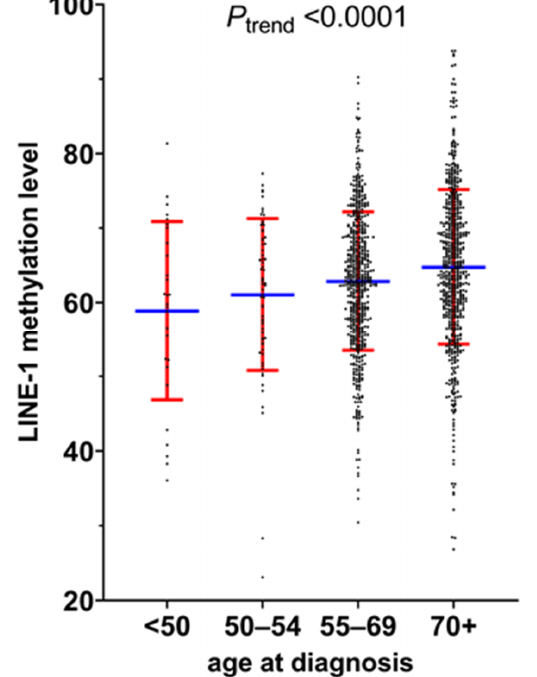
Figure 4. Distribution of tumor LINE-1 methylation levels in different age groups. In the scatter dot plot, the blue horizontal bar marks the mean and the red horizontal bar indicates the standard deviation of tumor LINE-1 methylation levels in each age group. A significant difference was observed between four age groups ( ≥ 70, 55–69, 50–54, and <50) ( P trend <0.0001). Abbreviation: LINE-1, long interspersed nucleotide element-1. Table 2. Linear regression analysis to predict LINE-1 methylation level (outcome) by four age groups (predictor).